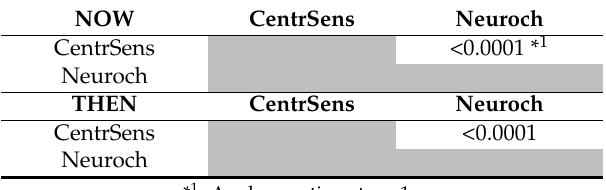
Table A9. Hypothalamic–pituitary–adrenal axis 2: “Central sensitisation” and biochemistry.